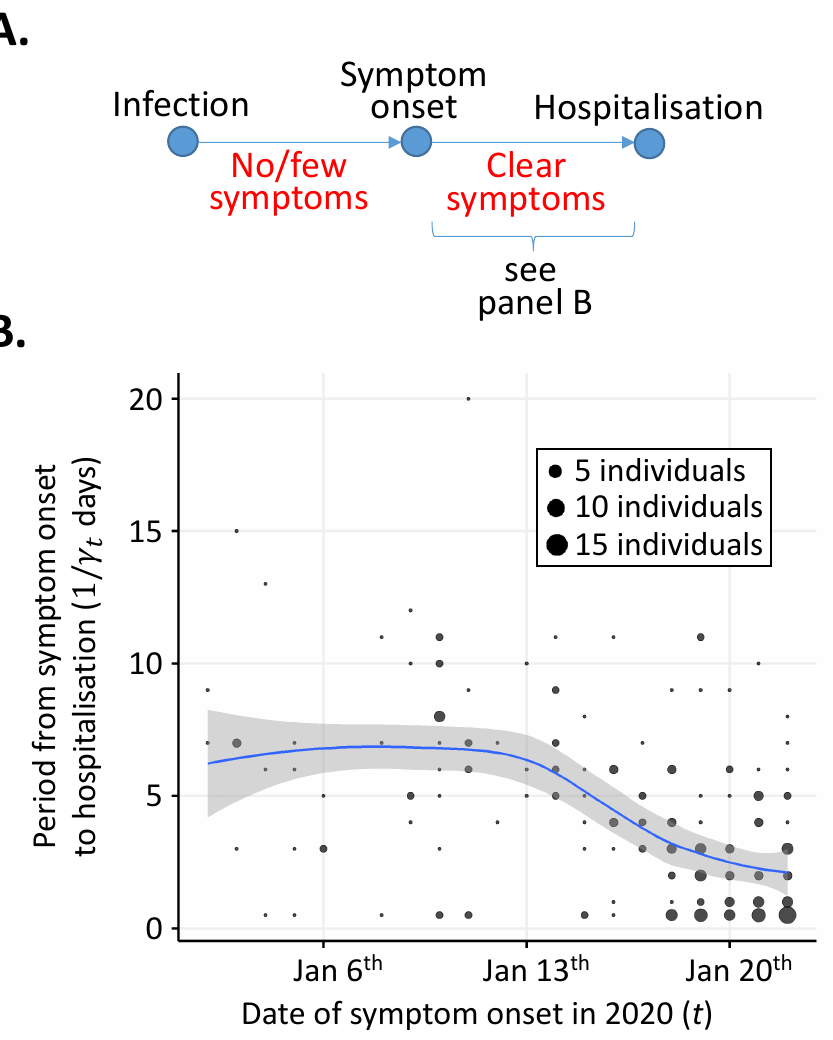
Figure 1. Changes in the period between symptom onset and hospitalisation (the assumed symptomatic infectious period) from 2 January 2020 to 22 January 2020. ( A ) Schematic showing the assumed epidemiology of infected hosts. Infected individuals initially have no or few symptoms. Later in infection, infected individuals develop clear symptoms. ( B ) Estimated mean period between symptom onset and hospitalisation (blue), along with the corresponding 95% confidence interval for the mean value (grey shaded region). Circle areas are proportional to the numbers of individuals with symptom onset date t who were hospitalised 1/ γ t days